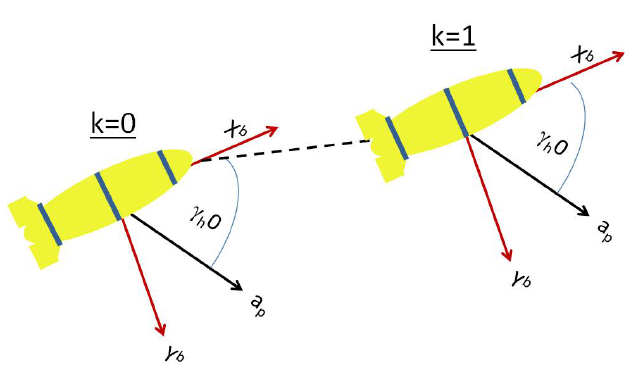
Figure 4. Illustration of the DR navigation process in the horizontal